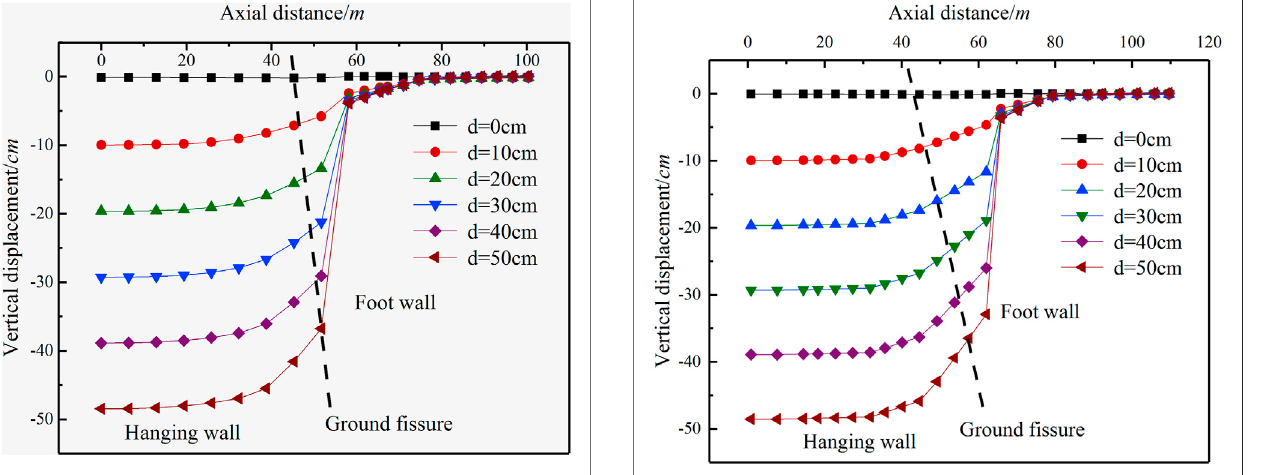
FIGURE 5| Vertical displacement of surface curve ofunderground utility tunnel obliquely crossing the ground fi ssure (inclination 90 ° ).